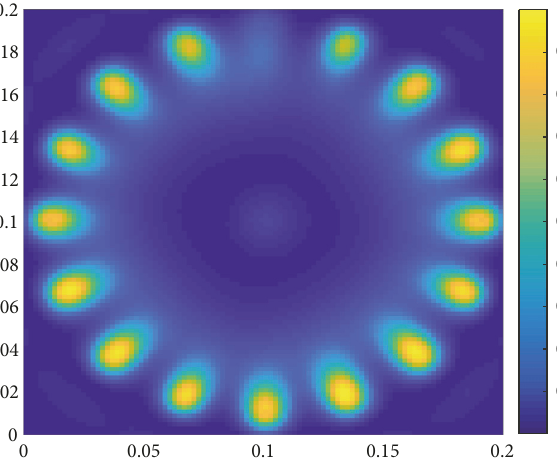
Figure 3: Single circular air defect inversion imaging diagram.